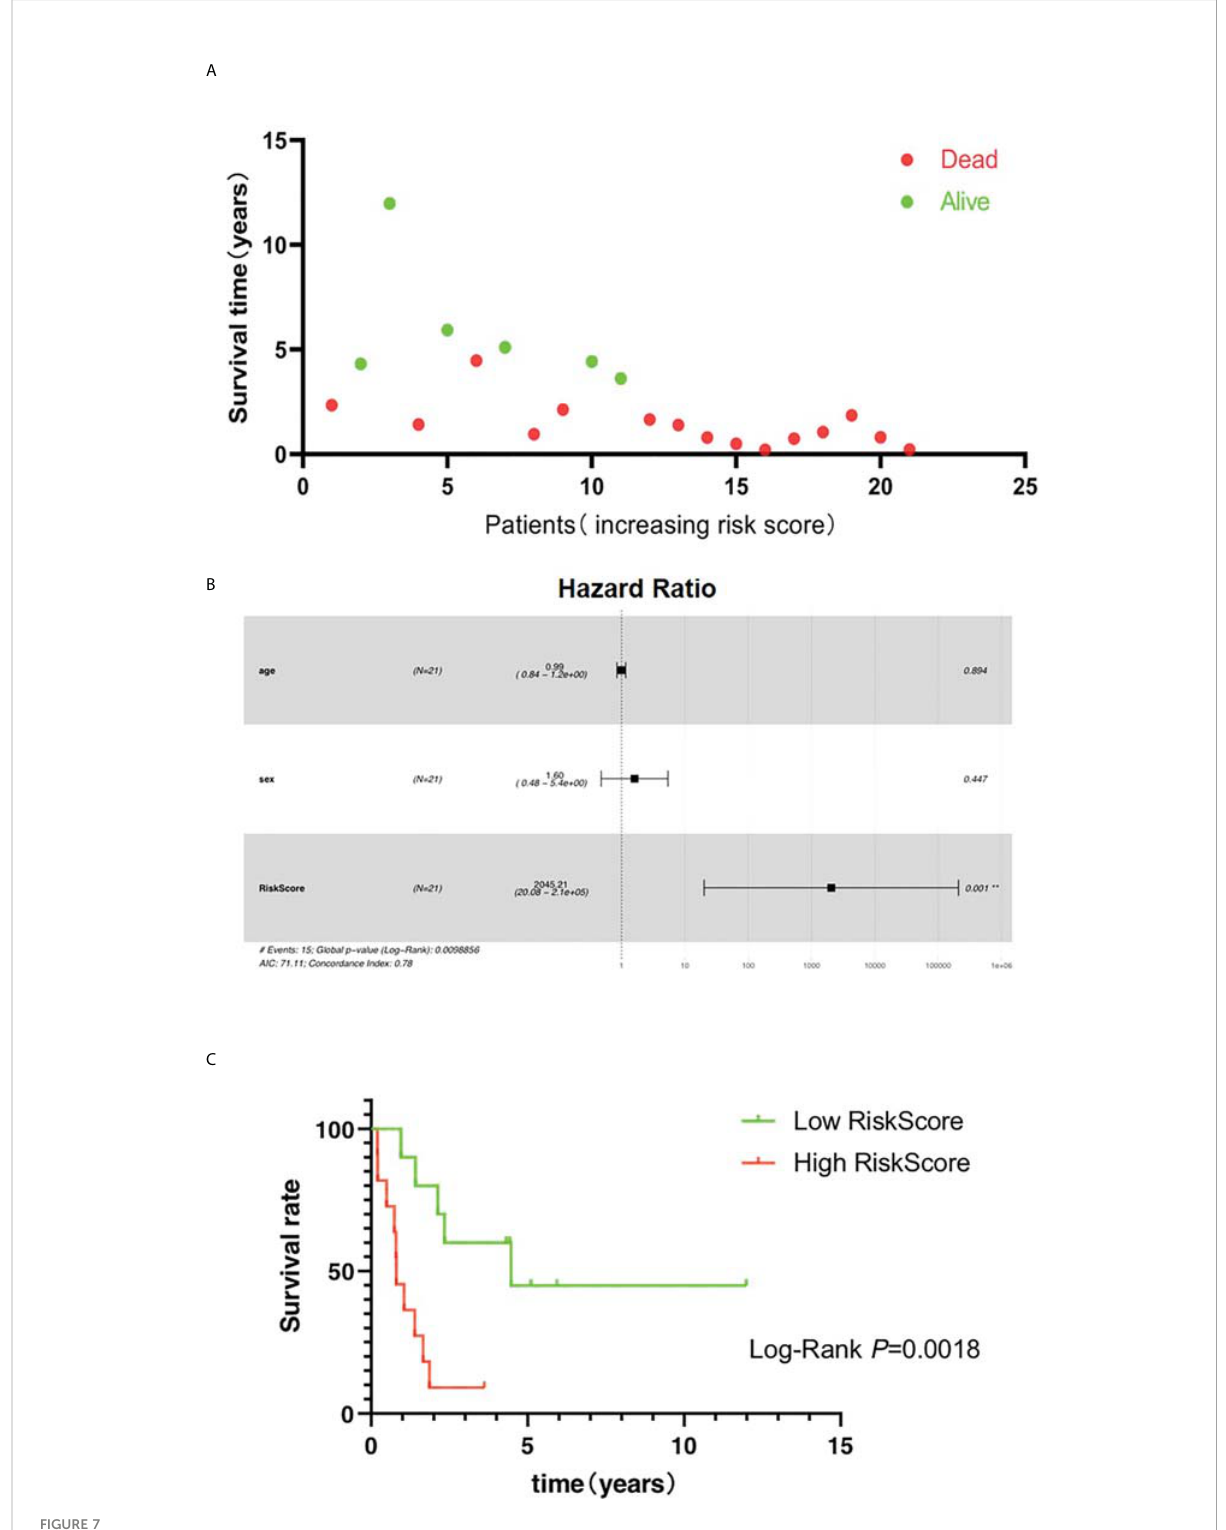
FIGURE 7 Risk score is the major clinical factors related to overall survival of osteosarcoma patients. (A) The distribution of survival time. (B) Multivariate Cox regression analyses of clinical factors with overall survival. (C) The K-M plot of the high risk and low risk